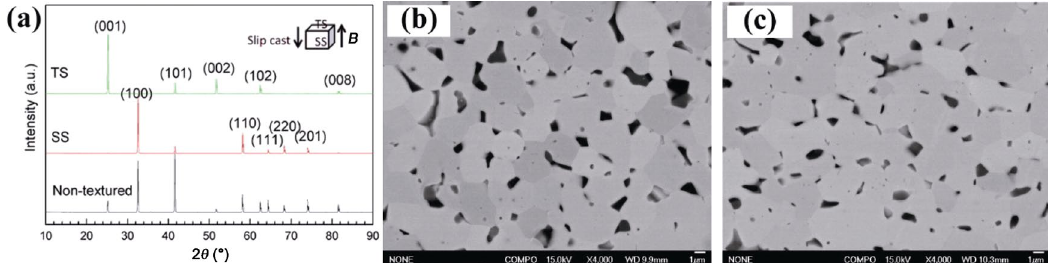
Fig. 33 XRD patterns and surface morphologies of textured ZrB 2 –5 vol% B 4 C composites prepared by magnetic alignment and SPS: (a) XRD patterns of TS and SS; (b, c) surface morphologies of TS and SS, respectively. Reproduced with permission from Ref. [251], © National Institute for Materials Science 2014.